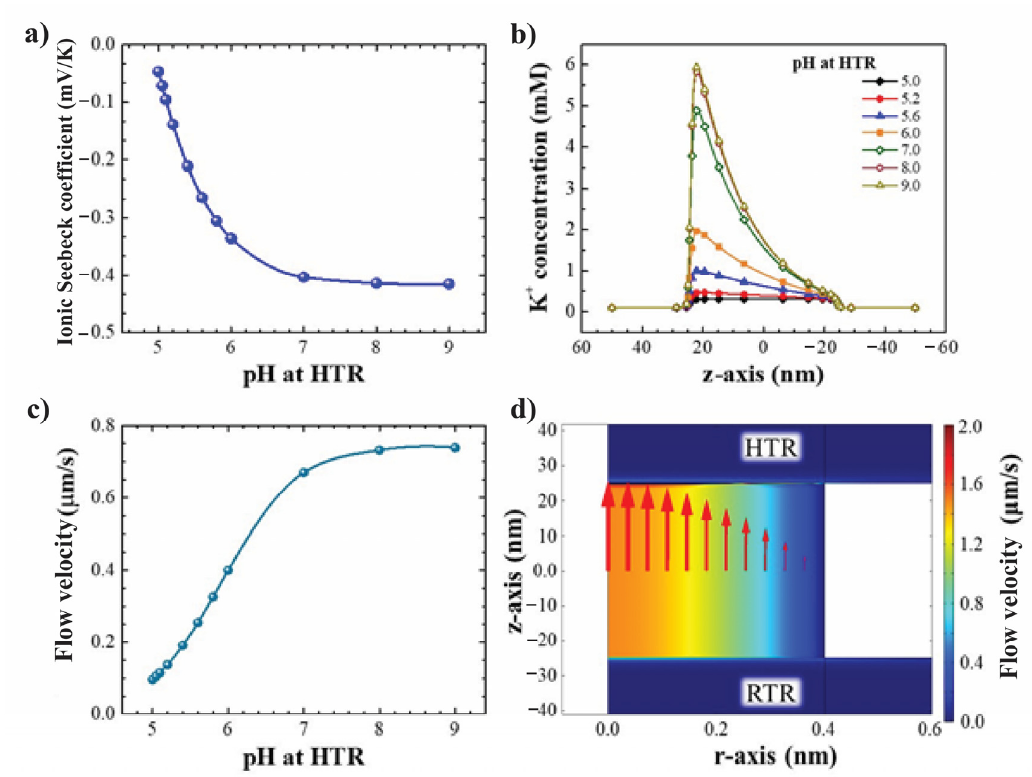
Figure 7. ( a ) Ionic Seebeck coefficient as a function of pH level at high-temperature reservoir. ( b ) K + concentrations along the centreline of nanopore with respect to different pH levels at high-temperature reservoir. ( c ) Velocity of fluid flow as a function of pH level at HTR, the maximum velocity of 0.73 μ m/s obtained at pH 9.0. ( d ) Flow field in nanopore (reservoirs are not in scale). Note that the pH level of RTR is fixed at 5.0.